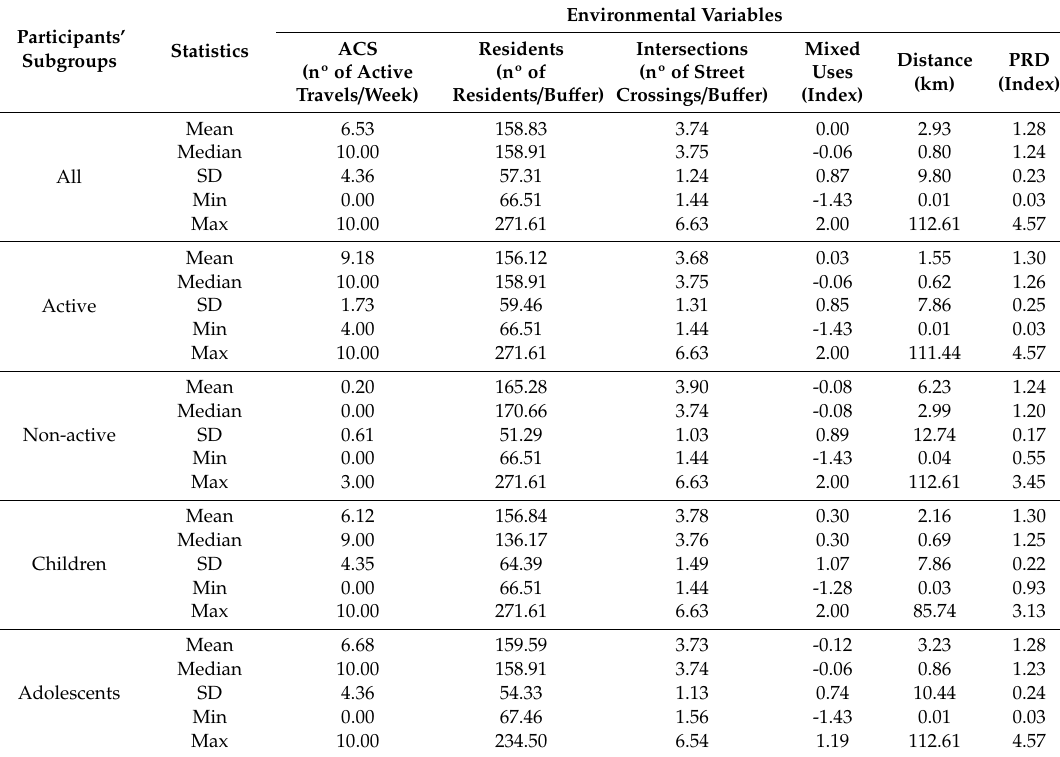
Table 2. Environmental variables descriptive statistics separately by participants’